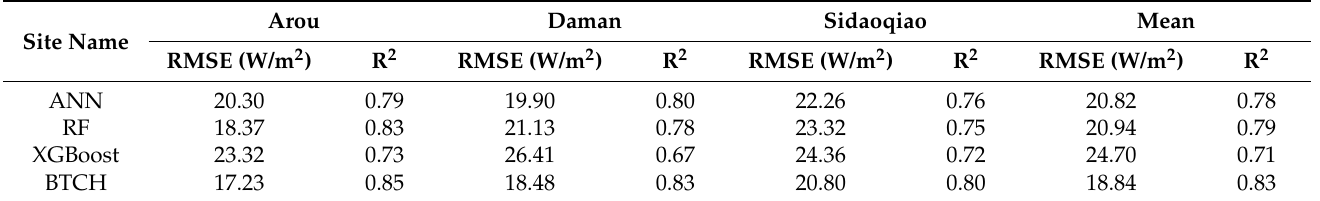
Table 6. Accuracy validation of latent heat flux simulated at upstream, midstream, and downstream LAS